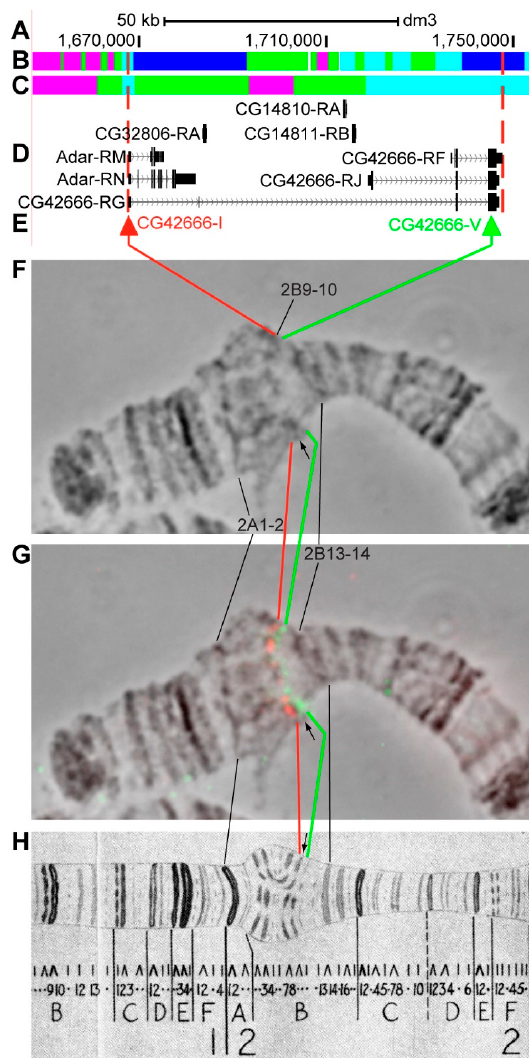
Figure 9. Localization of the CG42666 gene in the 2B region (the gene is bound by red dotted lines). ( A ) the scale (kb) and genomic coordinates (bp); ( B ) the four chromatin-state model [39]; ( C ) the chromatin condensation level model [32]; ( D ) genes location (arrow lines show the gene orientation and black bars indicate the location of gene exons); ( E ) probes location; ( F ) phase-contrast micrograph of the region; ( G ) combined FISH signals; and, ( H ) C. Bridges’ chromosome map